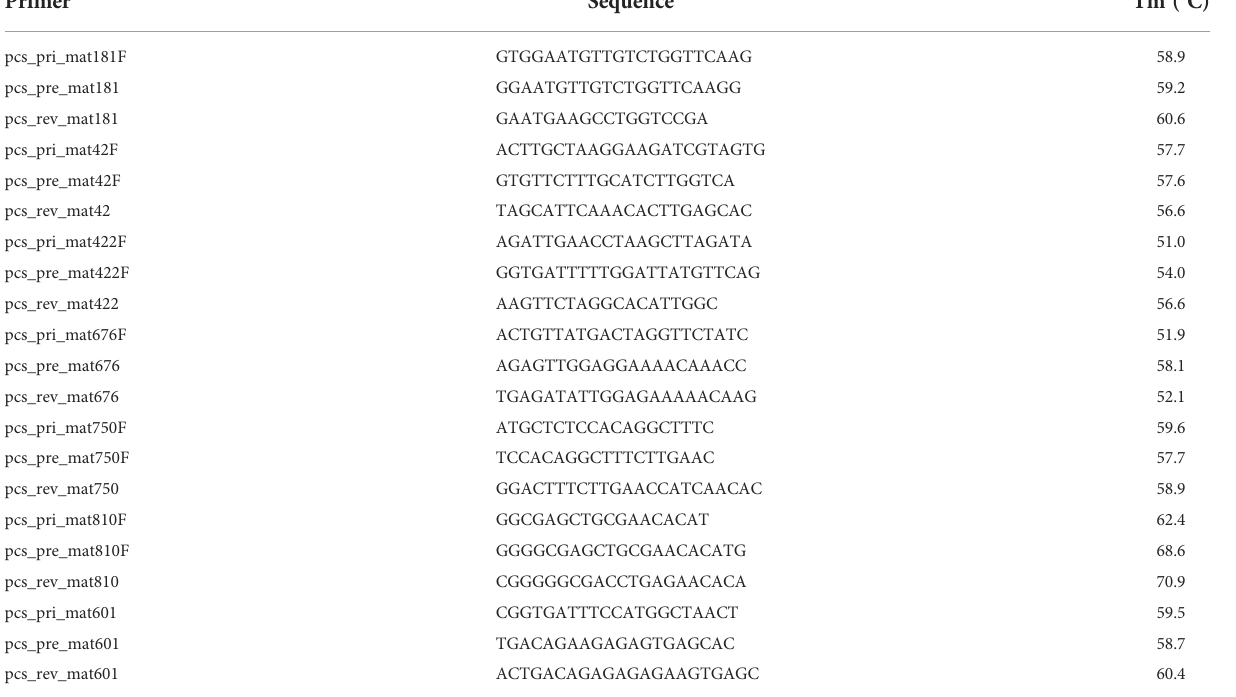
TABLE 3 Primers designed based on miRNA precursors identi fi ed in the Don Walter genome. Primer